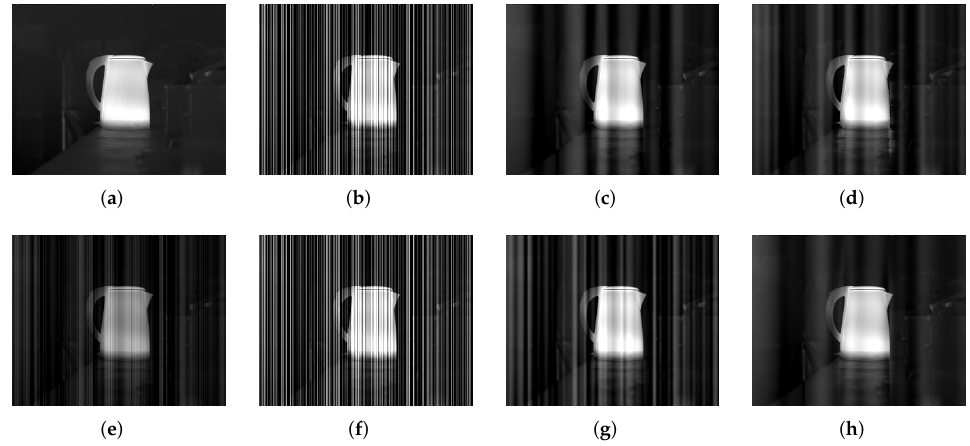
Figure 16. Filtered results for Kettle corrupted by stripe niose with σ = 0.32. ( a ) Clean; ( b ) Noisy; ( c ) WTSF; ( d ) MIRE; ( e ) GIF; ( f ) CNN; ( g ) Ours with i max = 2; ( h ) Ours with i max = 40.